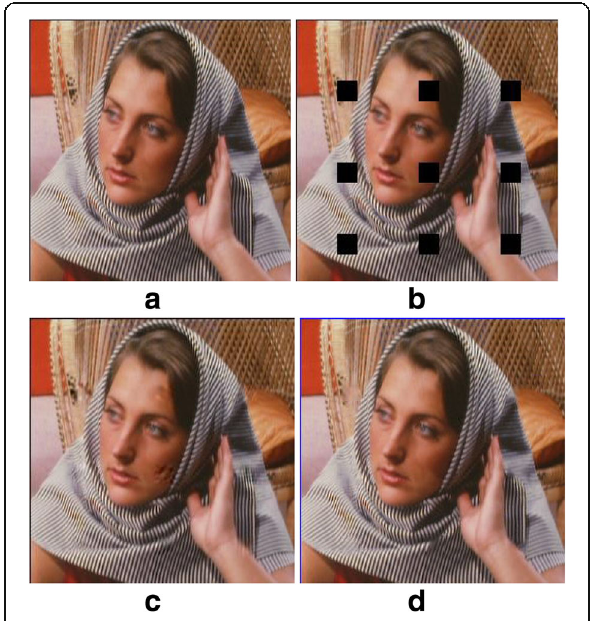
Fig. 7 Restoration of multiple missing blocks. a Original image. b Mask. c Crinimisi. d Proposed